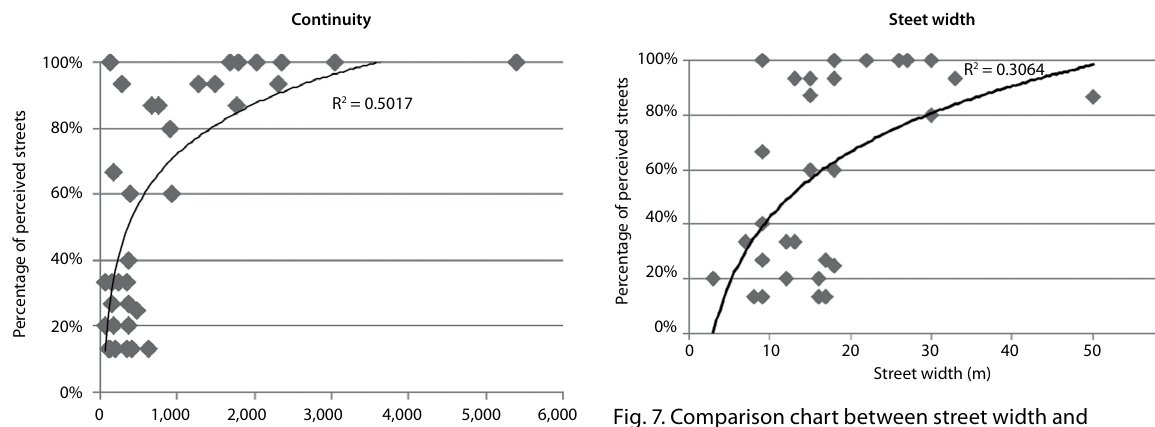
fig. 7. Comparison chart between street width and percentage of perceived streets in Kenmore and Kendall